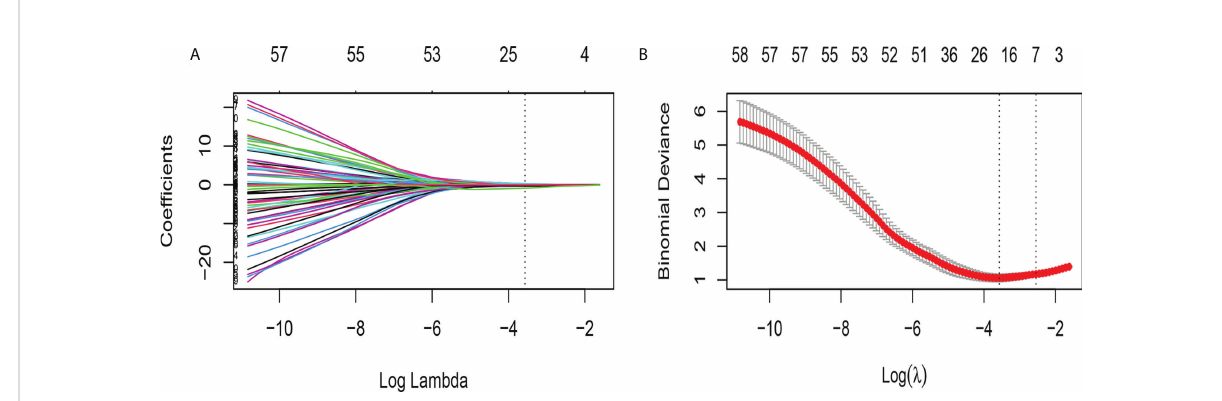
FIGURE 4 Feature selection using the LASSO binary logistic regression model. (A) LASSO coef fi cient pro fi les, displaying 68 features. A coef fi cient pro fi le plot was produced against the log (lambda) sequence. Each colored line represents the coef fi cient of an individual feature. A vertical line is drawn at the selected l , where 16 features had nonzero coef fi cients. (B) Tuning parameter (log lambda) selection in the LASSO model used ten- fold cross-validation via minimum criteria. Vertical dotted lines are drawn at the selected l values, corresponding to the chosen 16 variables that better fi t the models.